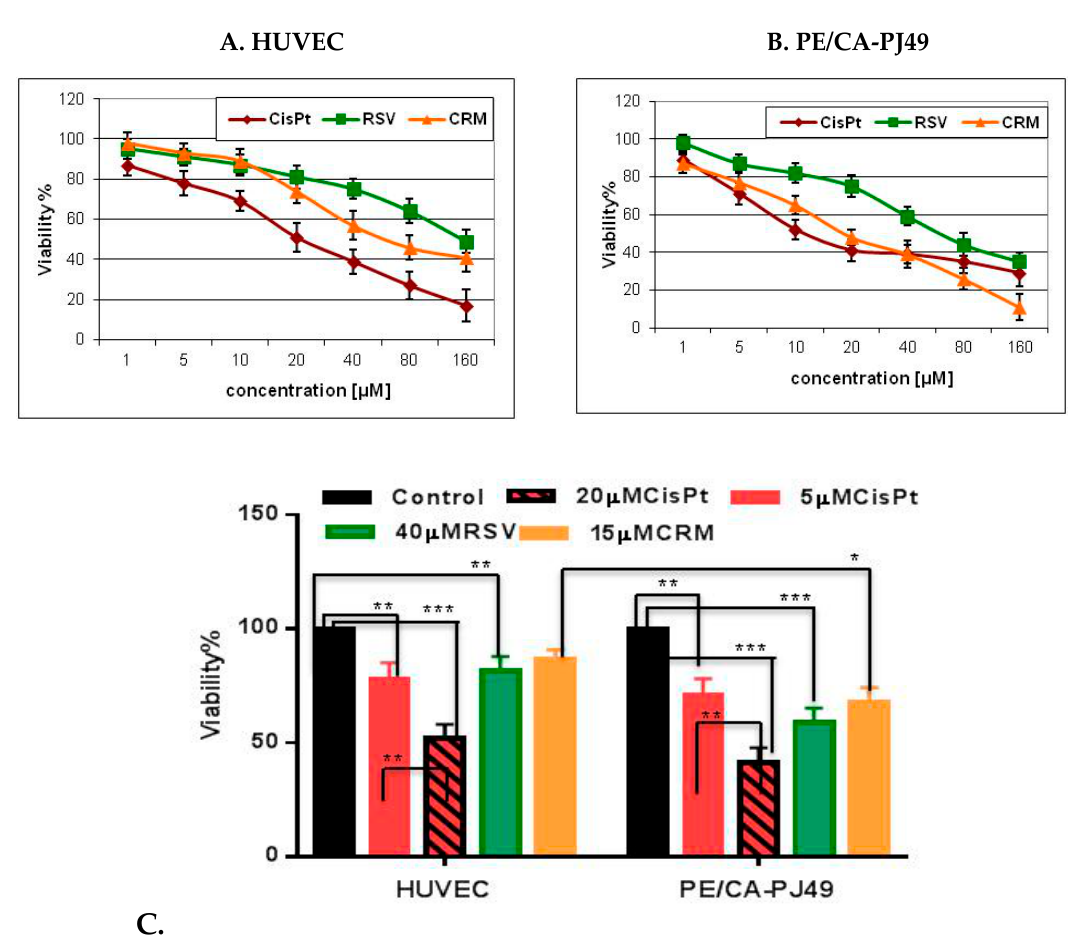
Figure 1. Cisplatin or natural compounds e ff ects on cells viability. ( A ) HUVEC and ( B ) PE / CA-PJ49 cells were either left untreated or treated 24 h with di ff erent concentrations of CisPt, CRM. Data shown are representative of three independent experiments and are expressed as mean of three replicates ± SD ( n = 3). Untreated cells were considered to have 100% viability. Viability% = (T − B) / (U − B) × 100, (where T, absorbance of treated cells; U, absorbance of untreated cells; and B, absorbance of blank). ( C ) Tumor cell viability compared to normal HUVEC cell viability after treatment with CisPt and / or RSV,CRM; (* p < 0.05, ** p < 0.005; *** p <